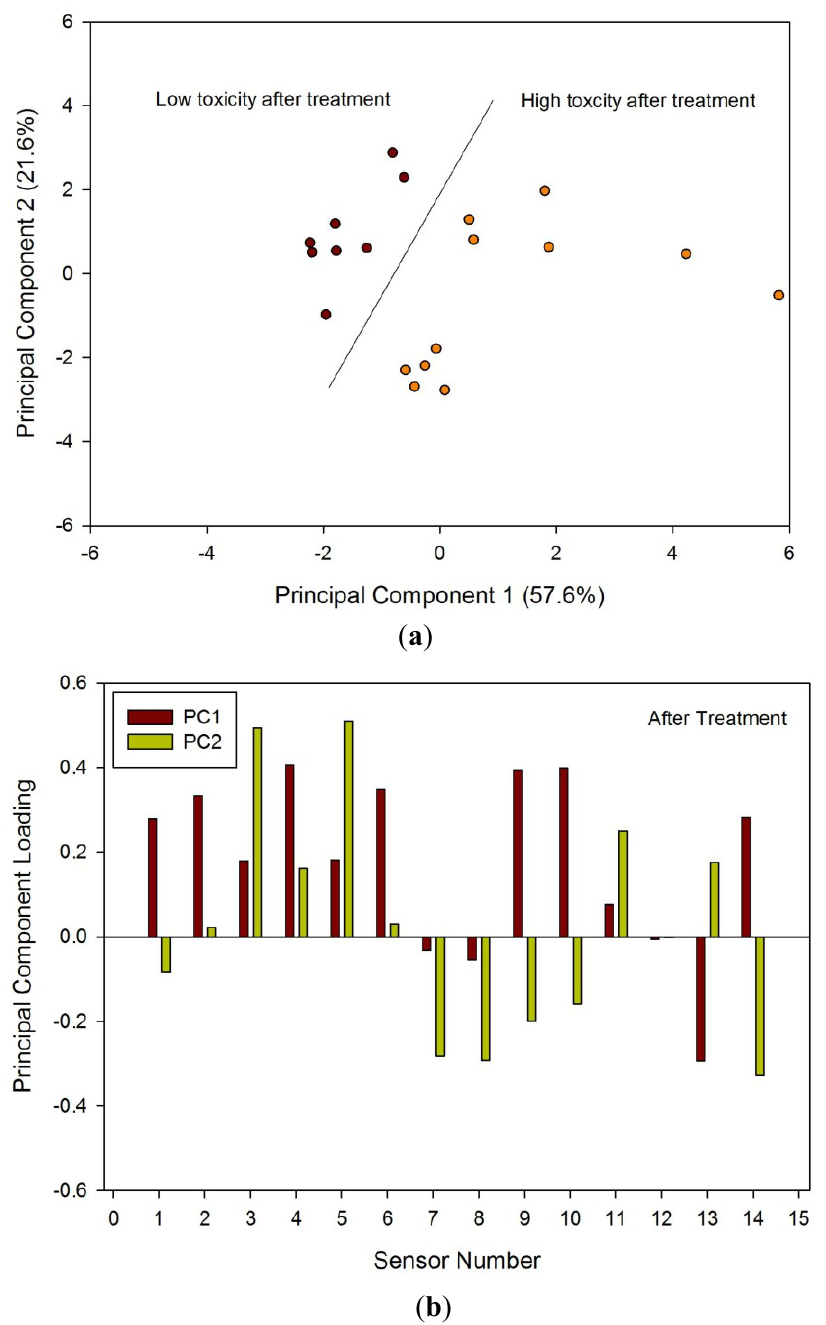
Figure 5. ( a ) PCA results from e-nose data and ( b ) loadings for samples taken four weeks after treatment referenced to Table